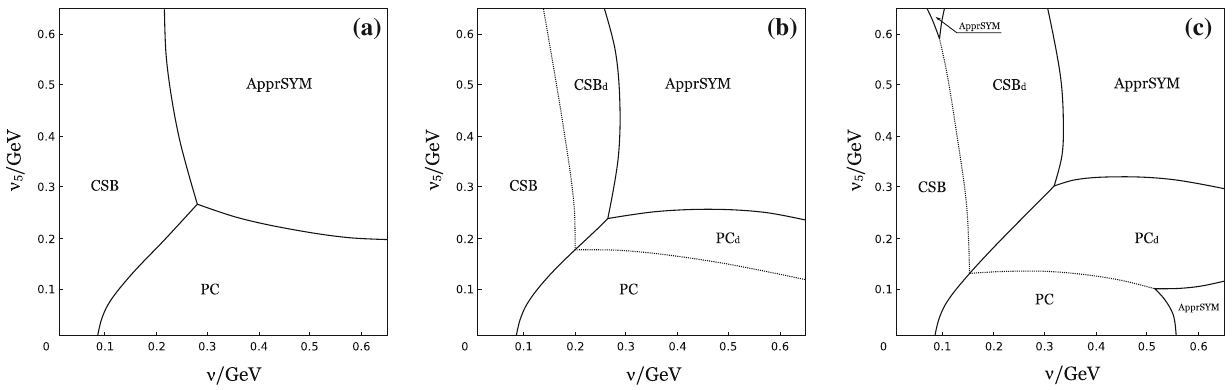
Fig. 2 The (ν,ν 5 ) -phase portraits of the model at the physical point ( m 0 = 5 . 5MeV ) and at μ = 0MeV – ( a ); μ = 150MeV – ( b ); and μ = 200MeV – ( c )